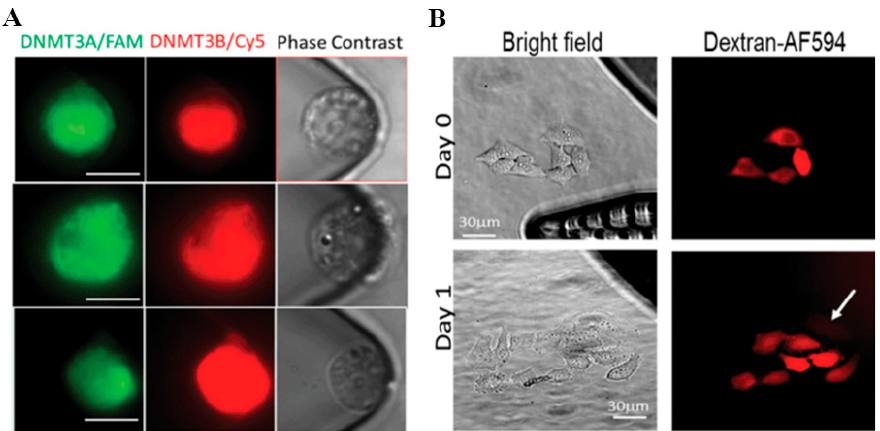
Figure 11. Monitor intracellular biomarker within individual living cells by molecular beacon probes. ( A ) micrographs of wild-type Kasumi-1 AML cells transfected with DNMT3A/B MBs. Reprinted with permission from ref. [85]. ( B ) HeLa cells transfected with MBs and imaged after 24 h of incubation showing that the electroporated cells divided. Reprinted with permission from ref.